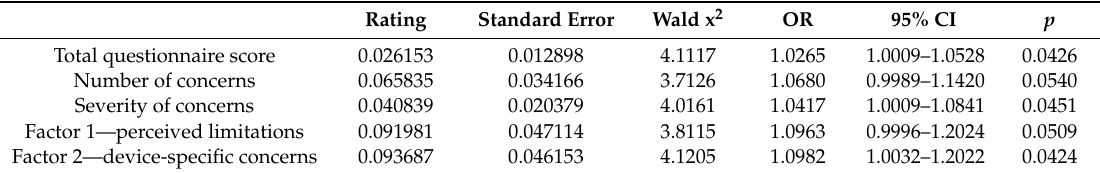
Table 5. Logistic regression analysis of frailty and the concerns after implantable cardioverter defibrillator (ICD) implantation.